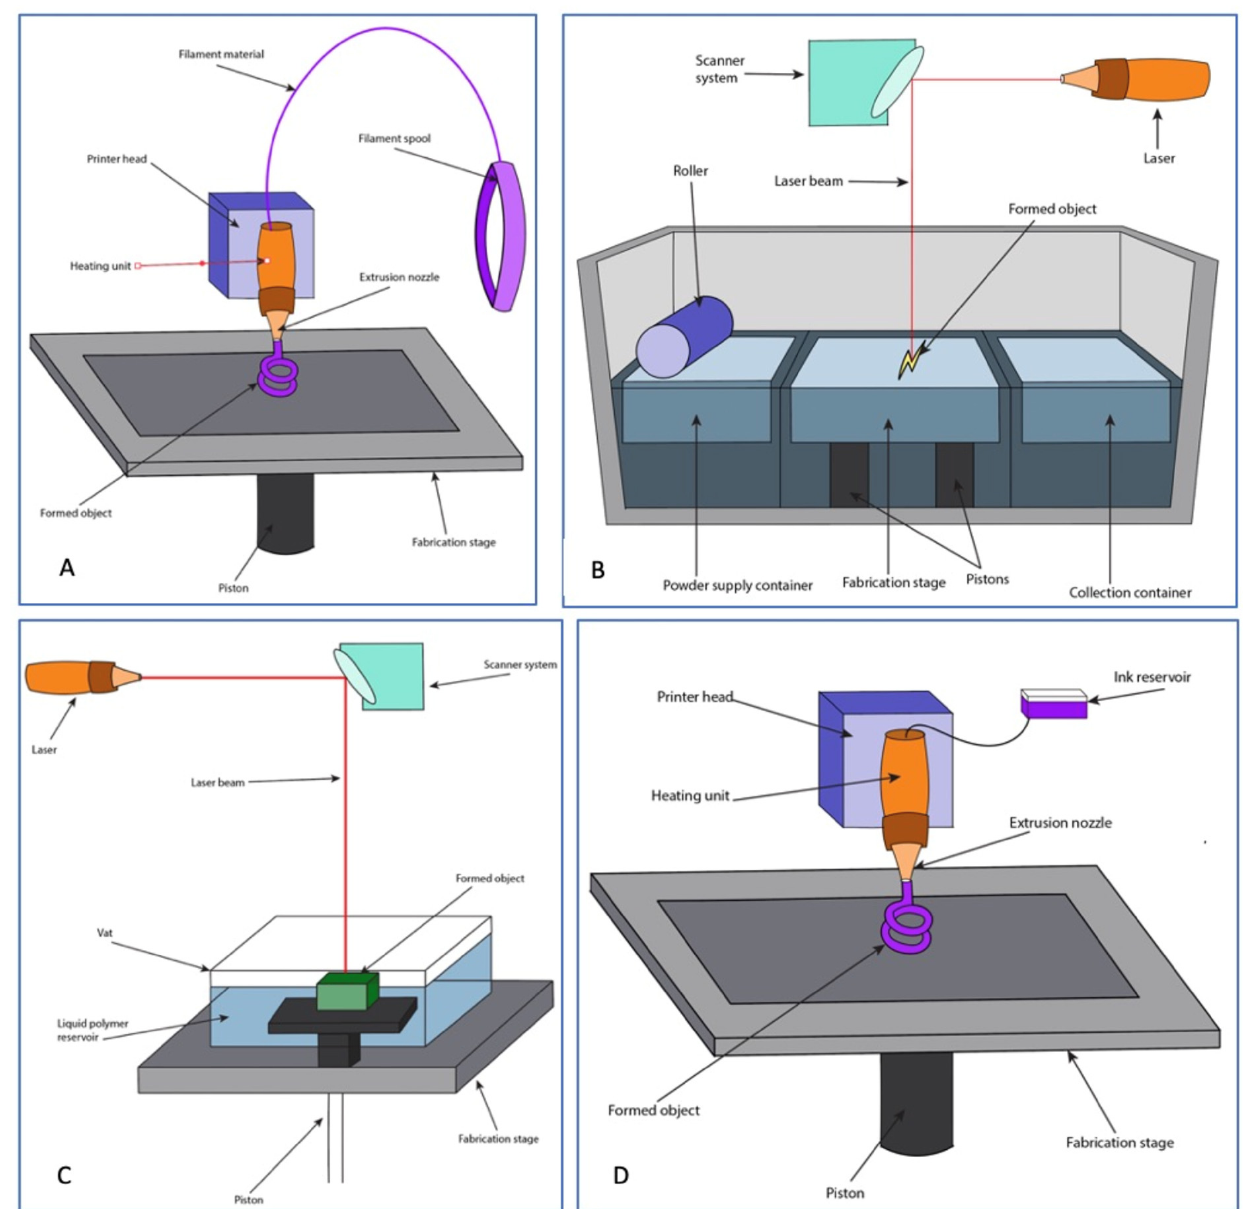
Figure 4. Schematic representations of 3-D printing techniques. ( A ) Fused deposition modeling. ( B ) Selective laser sintering. ( C ) Stereolithography. ( D ) Robotic material extrusion (robocasting).